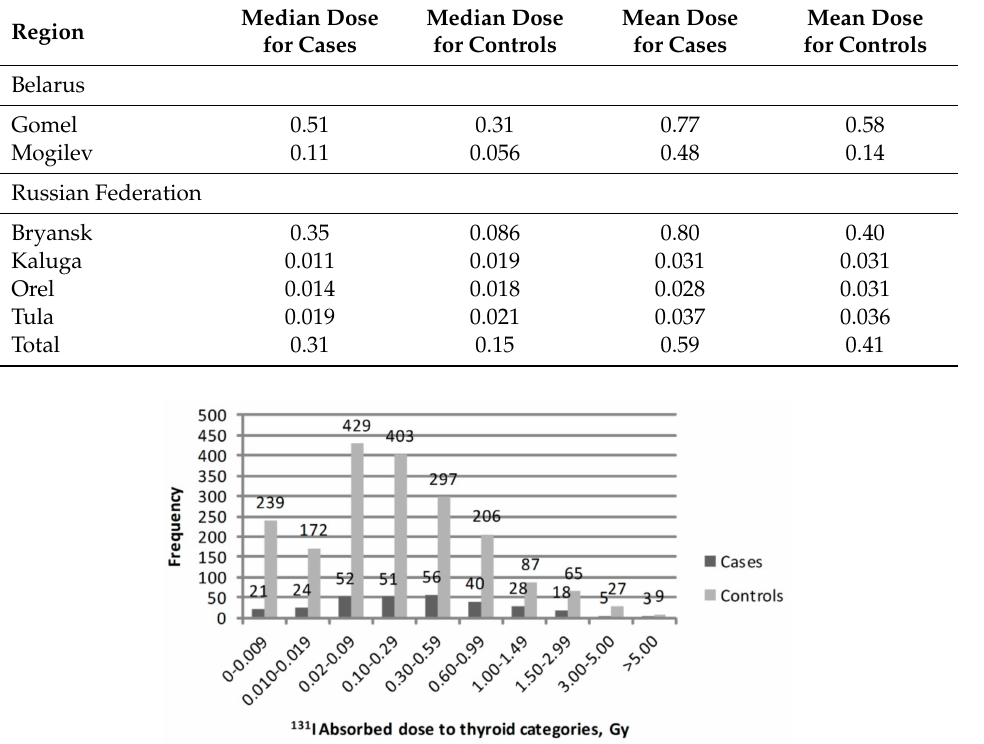
Table 2. Iodine-131 ( 131 I) thyroid dose estimates by case or control status and study region, in grays (Gy).